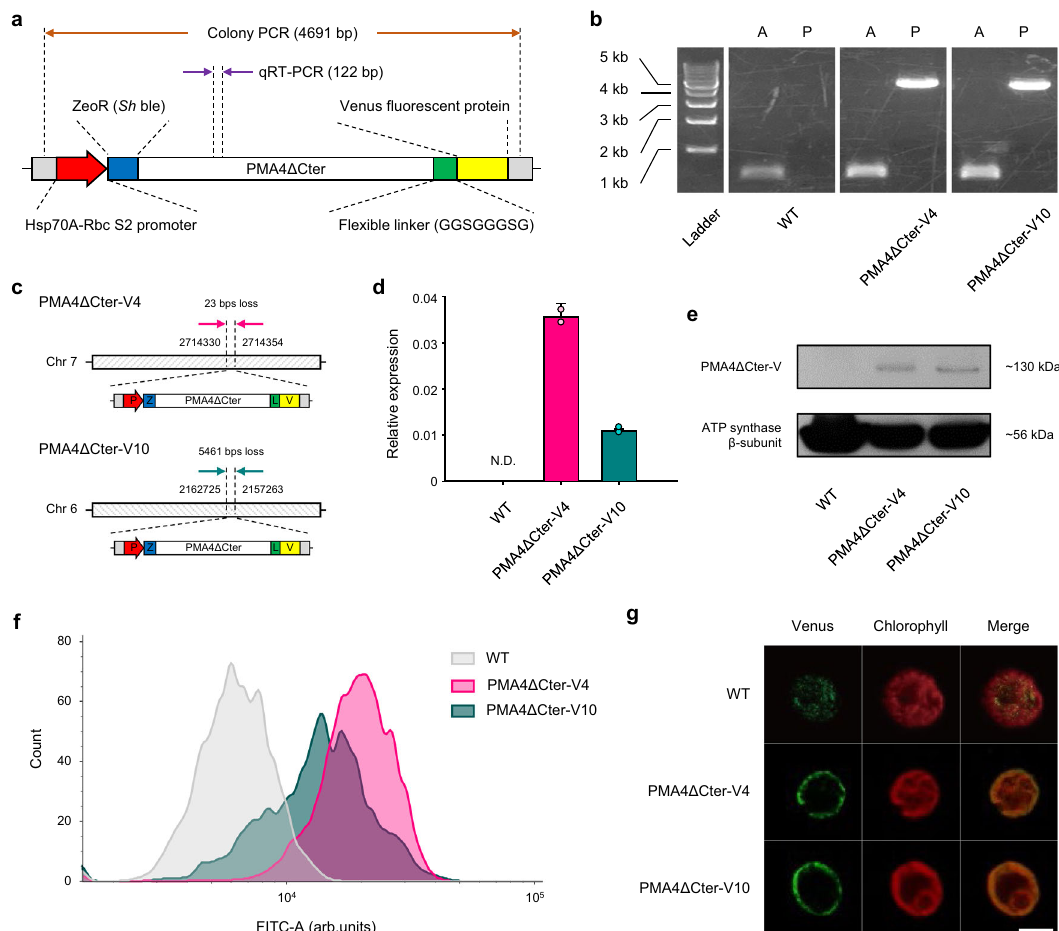
Fig. 2 Mutant construction and con fi rmation. a Simpli fi ed schematic representation of the codon-optimized PMA4 Δ Cter-V (PMA4 protein whose autoinhibitory domain in the C-terminus was deleted and fused with a fl uorescent Venus tag) insert (total 6835 bp). The gene scheme is not to scale. b Genotyping of two Zeocin-resistant colonies by PCR to con fi rm insertion. A and P indicate the actin (an endogenous control) gene (expected amplicon length: 501 bp) and the PMA insert gene (expected amplicon length: 4691 bp), respectively. c Identi fi cation of the insertion site revealed by NGS. In the transgenic algal cells, a single insert was con fi rmed. In the cartoon, Chr, P, Z, L, and V represent chromosome, promoter, Zeocin resistance, linker, and Venus tag, respectively. The scheme is not to scale. d mRNA expression veri fi cation by qRT-PCR. Data are the mean ± SD of two biological replicates. The relative expression levels were normalized to the expression levels of a housekeeping gene (IDA5). N.D. stands for not detected. e Western blotting analysis for con fi rming protein expression. The expression of the ATP synthase β -subunit was simultaneously examined as an endogenous control. f Fluorescence analysis of the expressed protein by fl ow cytometry. Details of gating strategy used for the analysis is described in Supplementary Method 5 and Supplementary Fig. 9a – d. g Representative confocal images (bar scale of 5 μ m) to con fi rm the proper localization of the exogenously expressed protein. In contrast to the results obtained for the WT strain, the fl uorescence signals were observed exclusively in the plasma membrane of the transgenic strains. Source data are provided as a Source Data fi